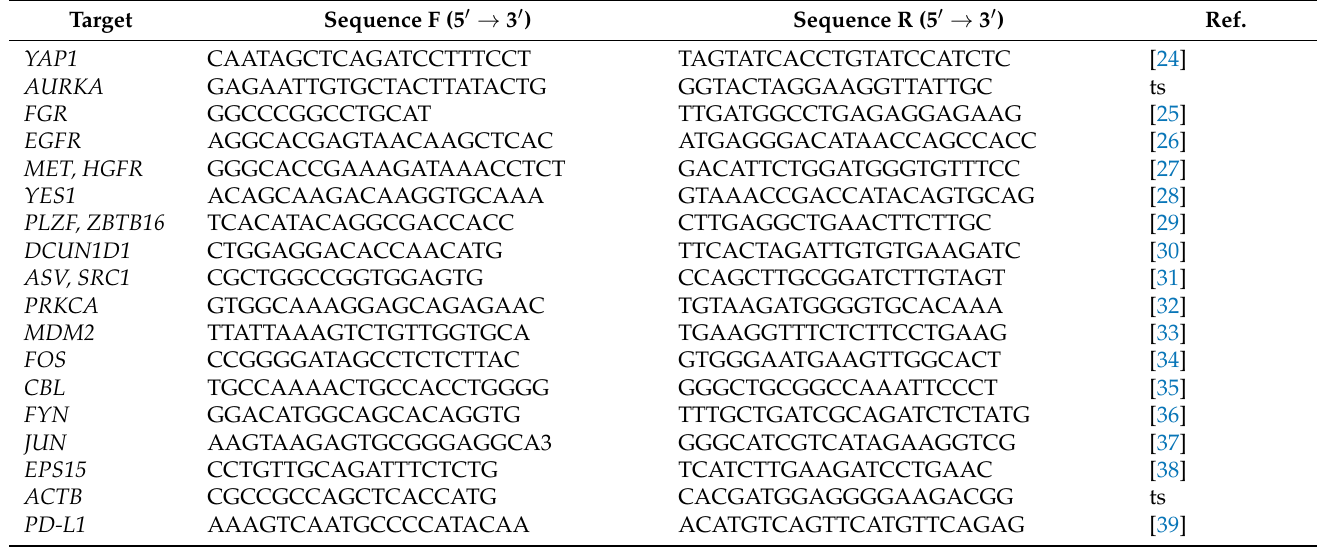
Table 1. List of